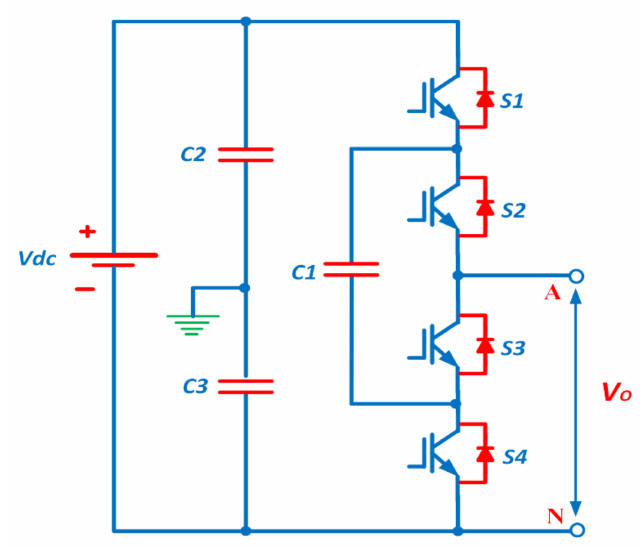
Figure 4. Three-level flying capacitor MLI